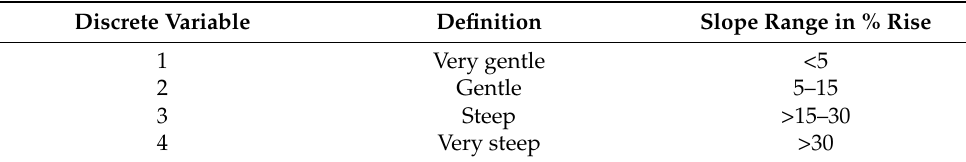
Table 5. Assignation to each category of soil slope.